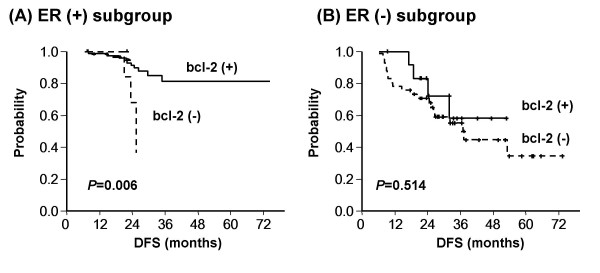
Disease-free survival according to bcl-2 status in (A) ER-positive and (B) ER-negative pateints. Bcl-2 (+) patients showed better disease-free survival even in those with an ER (+) status, suggesting that bcl-2 has a prognostic role that is independent of ER expression.